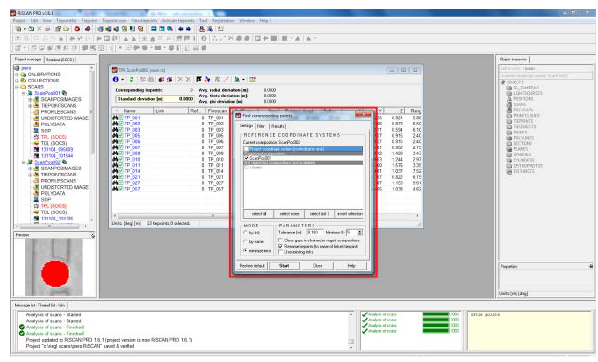
Figure 4: Registration into a PRCS-Project Coordinate System.